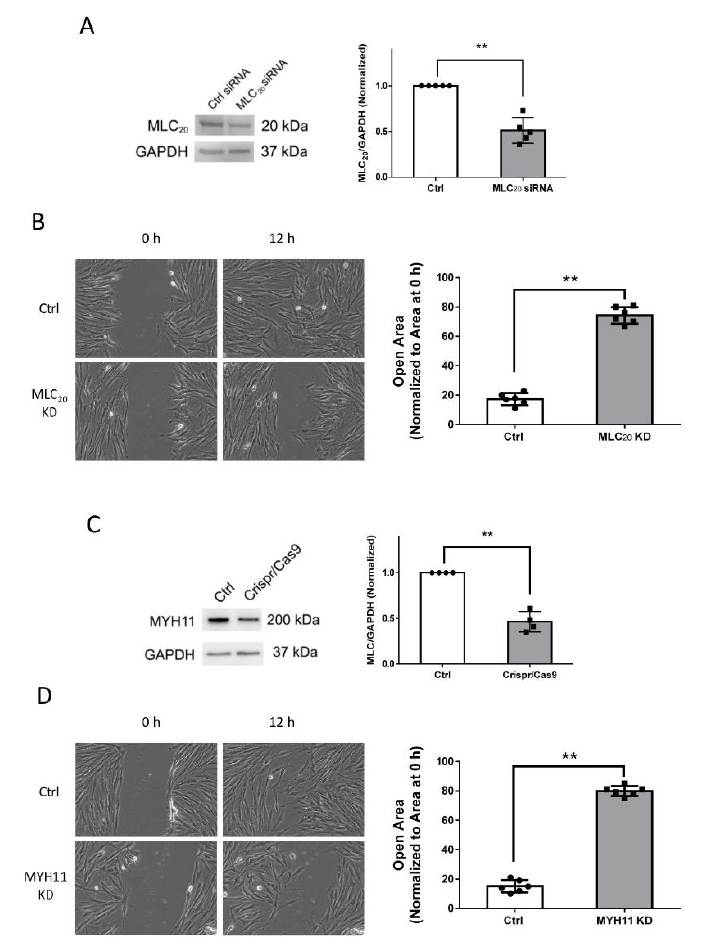
Figure 2. Knockdown (KD) of MLC 20 or MYH11 attenuates cell migration. ( A ) Human airway smooth muscle (HASM) cells treated with control (Ctrl) siRNA or MLC 20 siRNA were evaluated by immunoblot analysis. MLC siRNA reduces the expression of MLC 20 in HASM cells. Data are mean values of experiments from five cultures from three donors. Error bars indicate SD. ( B ) The migration of HASM cells was examined by using the wound healing assay. n = six experiments from three donors. Error bars indicate SD. ( C ) Cells were treated with Ctrl or Crispr/Cas9 constructs followed by immunoblot analysis. Data are the mean values of experiments from four cultures from three donors. Error bars indicate SD. ( D ) MYH11 KD reduces the migration of HASM cells. n = six experiments from three donors. Error bars indicate SD. ** p < 0.01. Student’s t -test was used for statistical analysis.